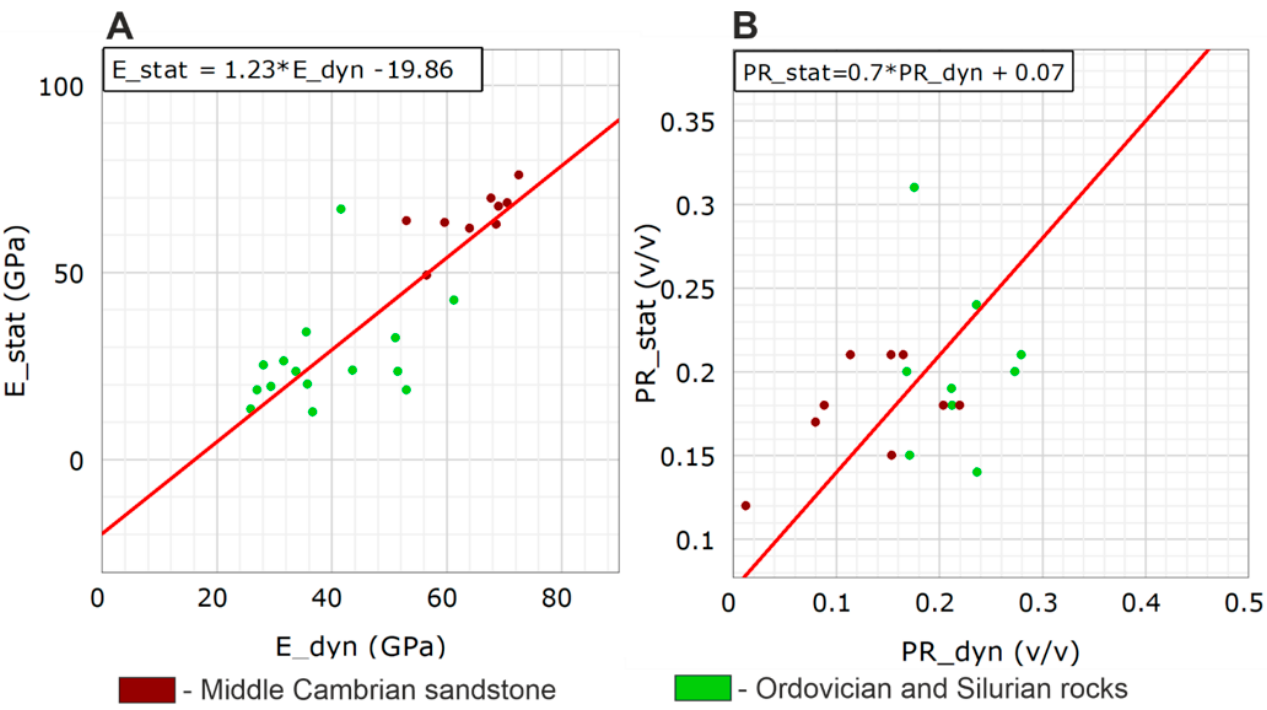
Figure 5. Cross-plot between static laboratory-measured ( A ) Young’s modulus values and dynamic Young’s modulus calculated from well logs, and ( B ) Poisson’s ratios and dynamic Poisson’s ratios calculated from well logs.